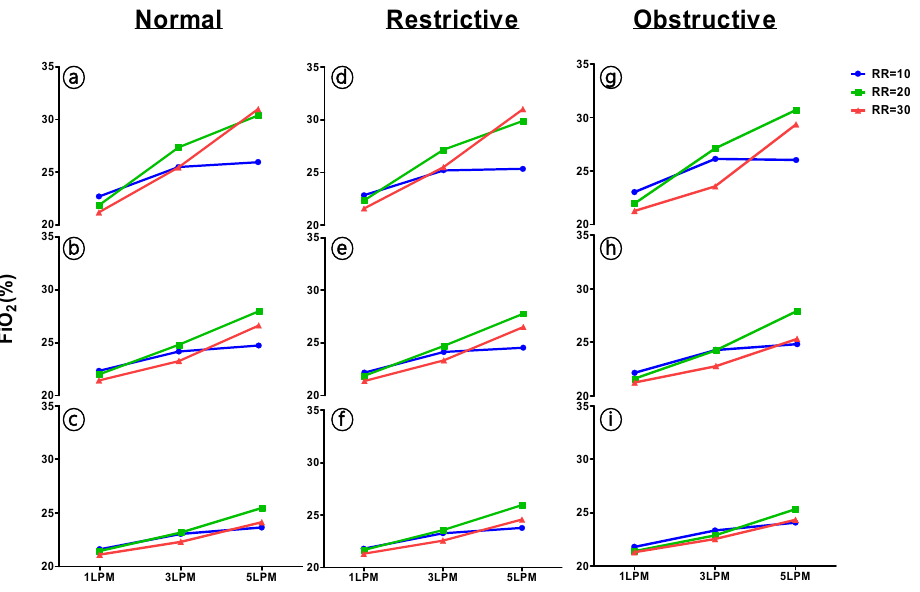
Figure 4. Effect of respiratory rate (RR) on FiO 2 . ( a , d , g ) V T : 300 mL.; ( b , e , h ) V T : 500 mL.; ( c , f , i ) V T : 700 mL.